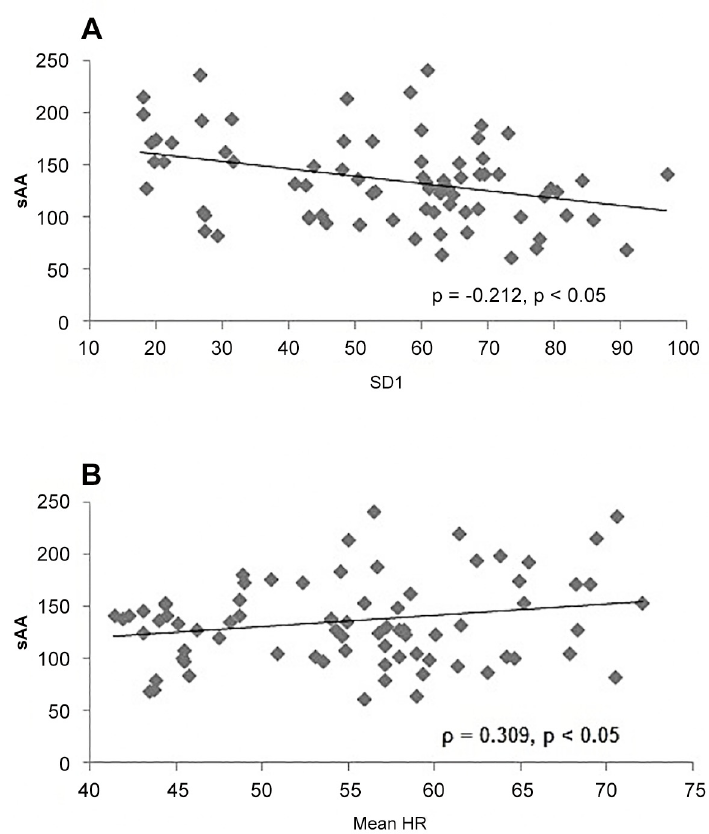
(HR). ρ — Spearman ’ s rank rho correlation coefficient